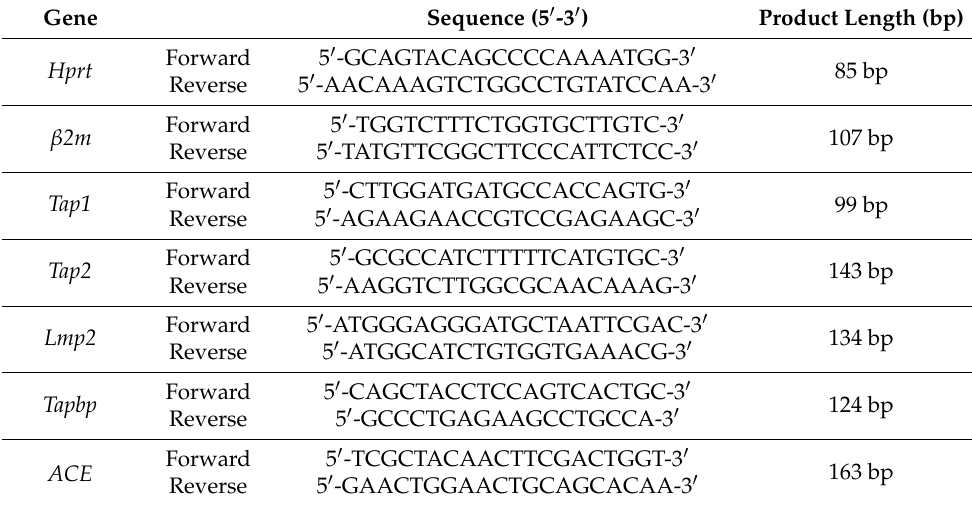
Table 1. List of DNA primer sequences used in RT-qPCR